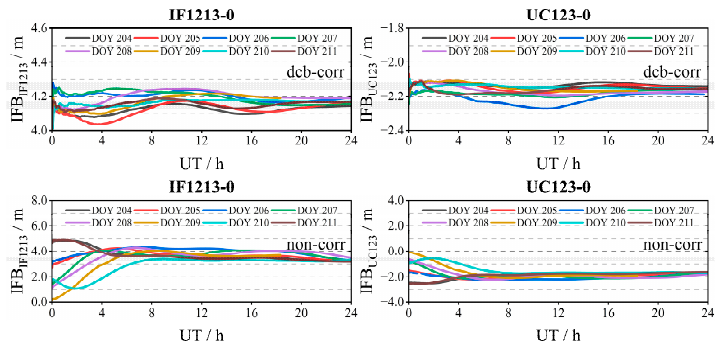
Figure 13. IFB of IF1213 and UC123 models at AREG.